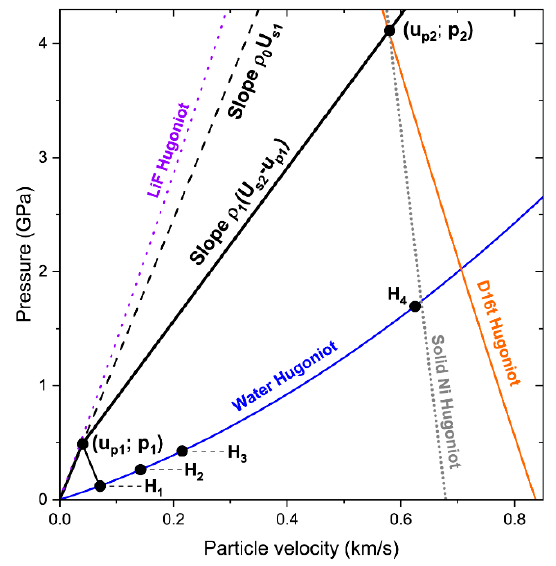
Figure 9. Pressure–particle velocity diagram for Experiment 5. The points H 1 –H 4 are the shocked states in the water window after the precursor (H 1 ), its reflections (H 2 , H 3 ), and compaction wave (H 4 ) arrivals. These were obtained using the water Hugoniot and the velocity profile (see Figure 10). The LiF Hugoniot is shown for comparison. The reflected solid Ni Hugoniot drawn from the point ( u p 2 , p 2 ) nearly crossed the point H 4 , which demonstrates that probably all pores of the sample were collapsed by the compaction wave.